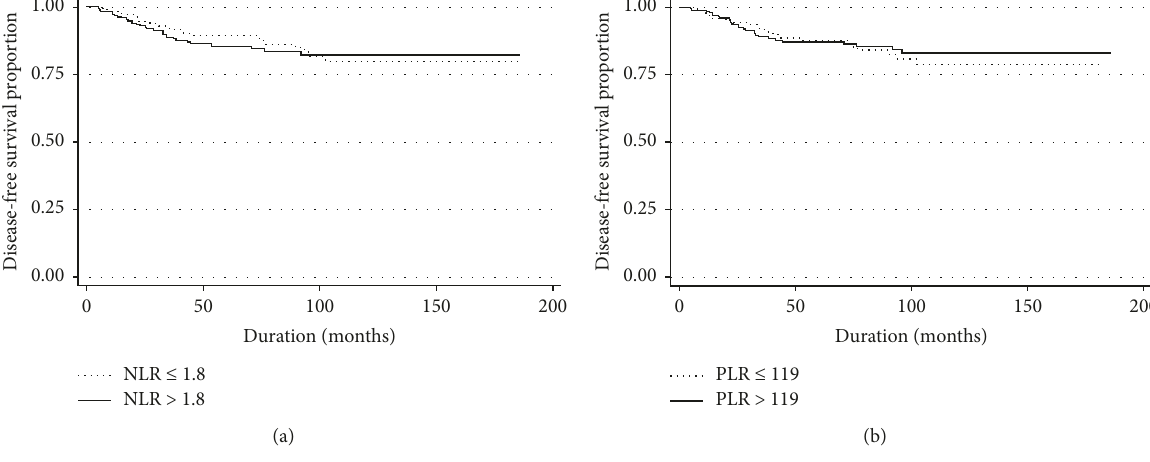
Figure 1: The disease-free survival according to neutrophil/lymphocyte ratio (a) and platelet/lymphocyte ratio (b).